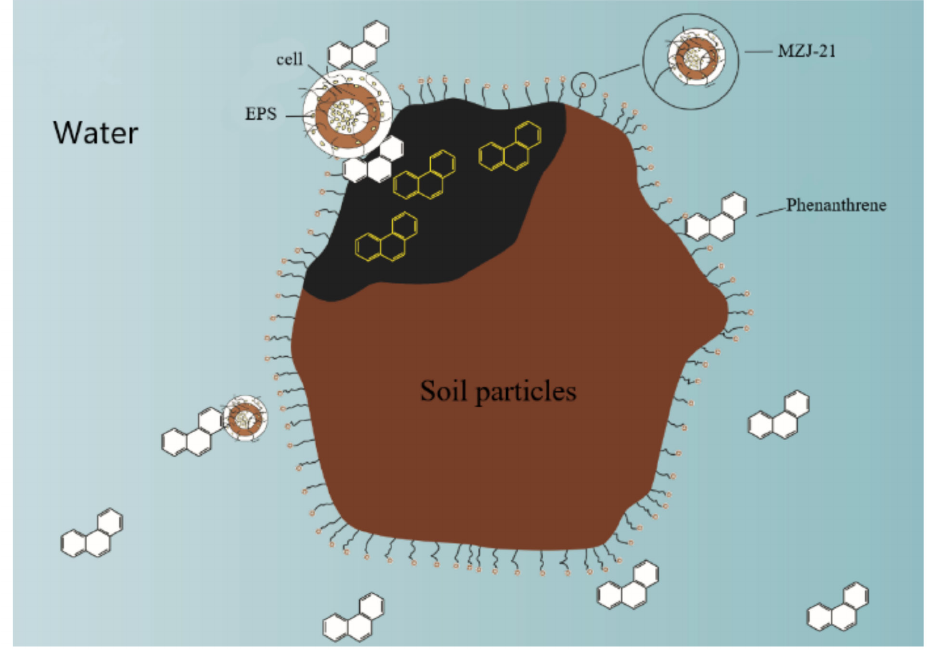
Figure 8. Strategy of phenanthrene degradation by MZJ_21 in solid